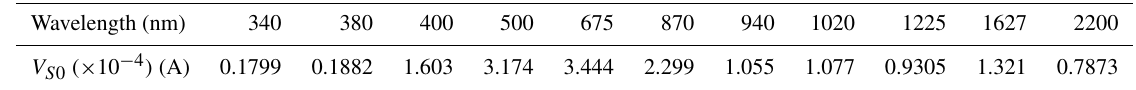
Table 1. Examples of calibration coefficient V S 0 for the solar measurement.